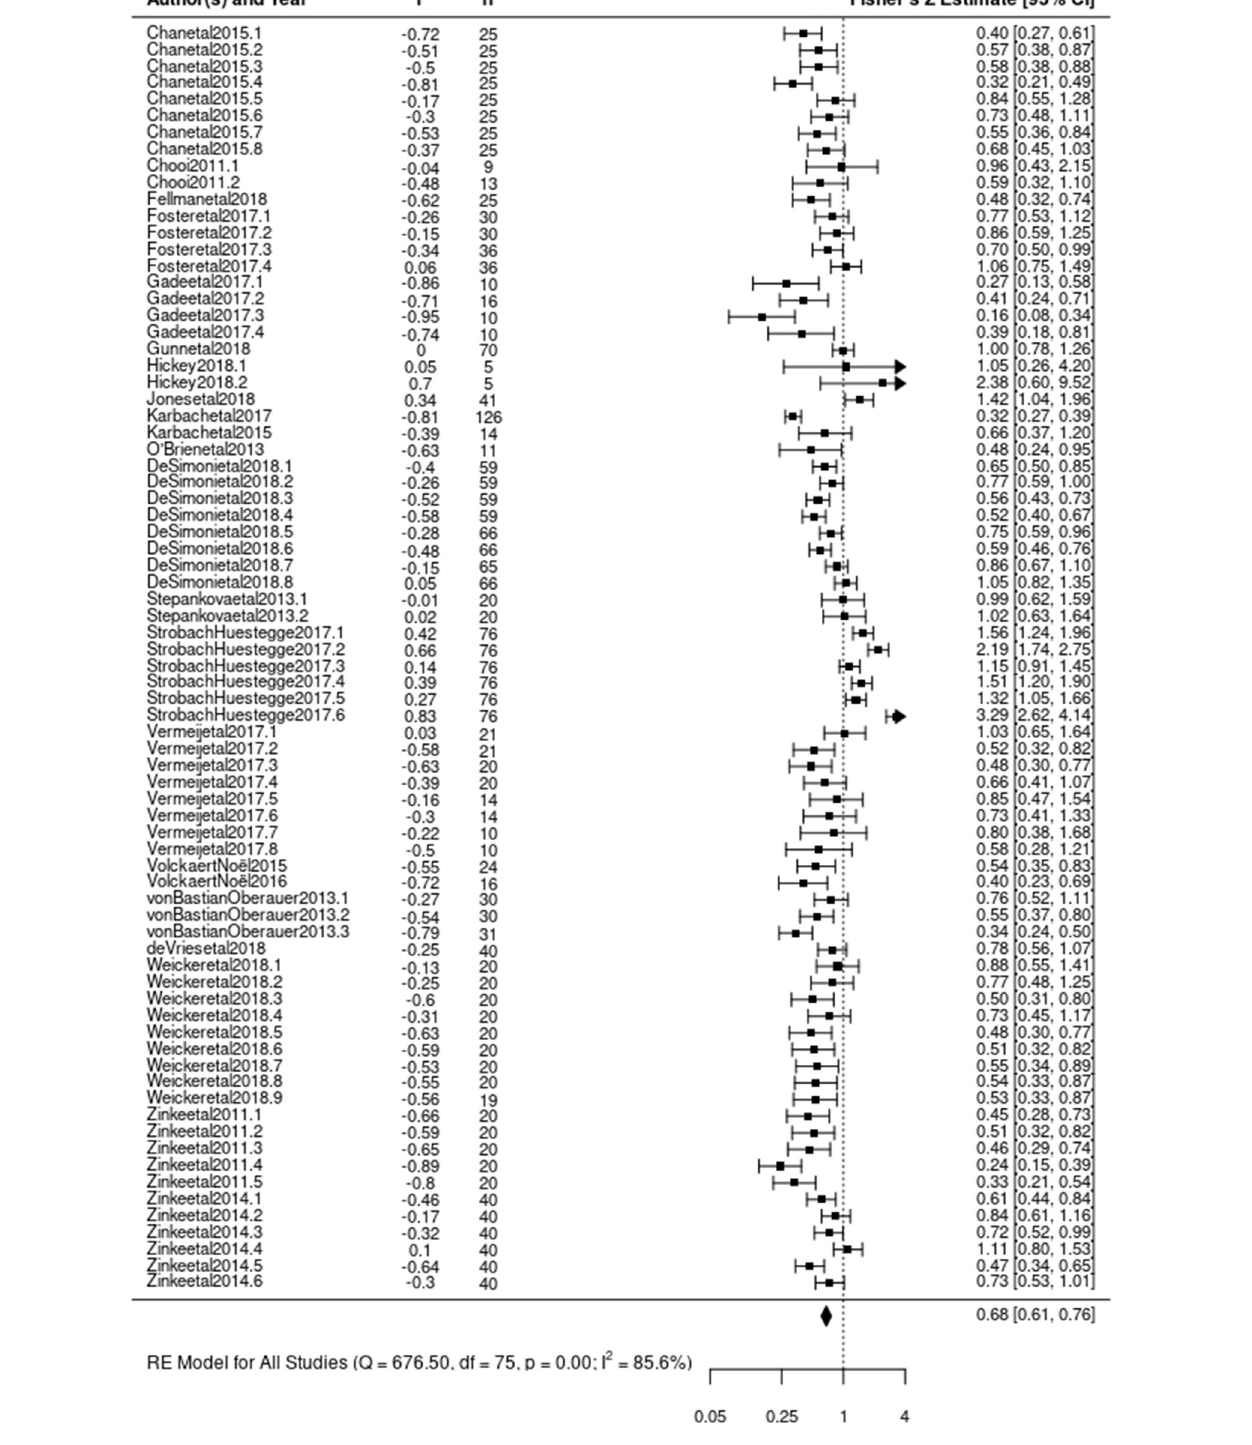
Frontiers in Psychology |